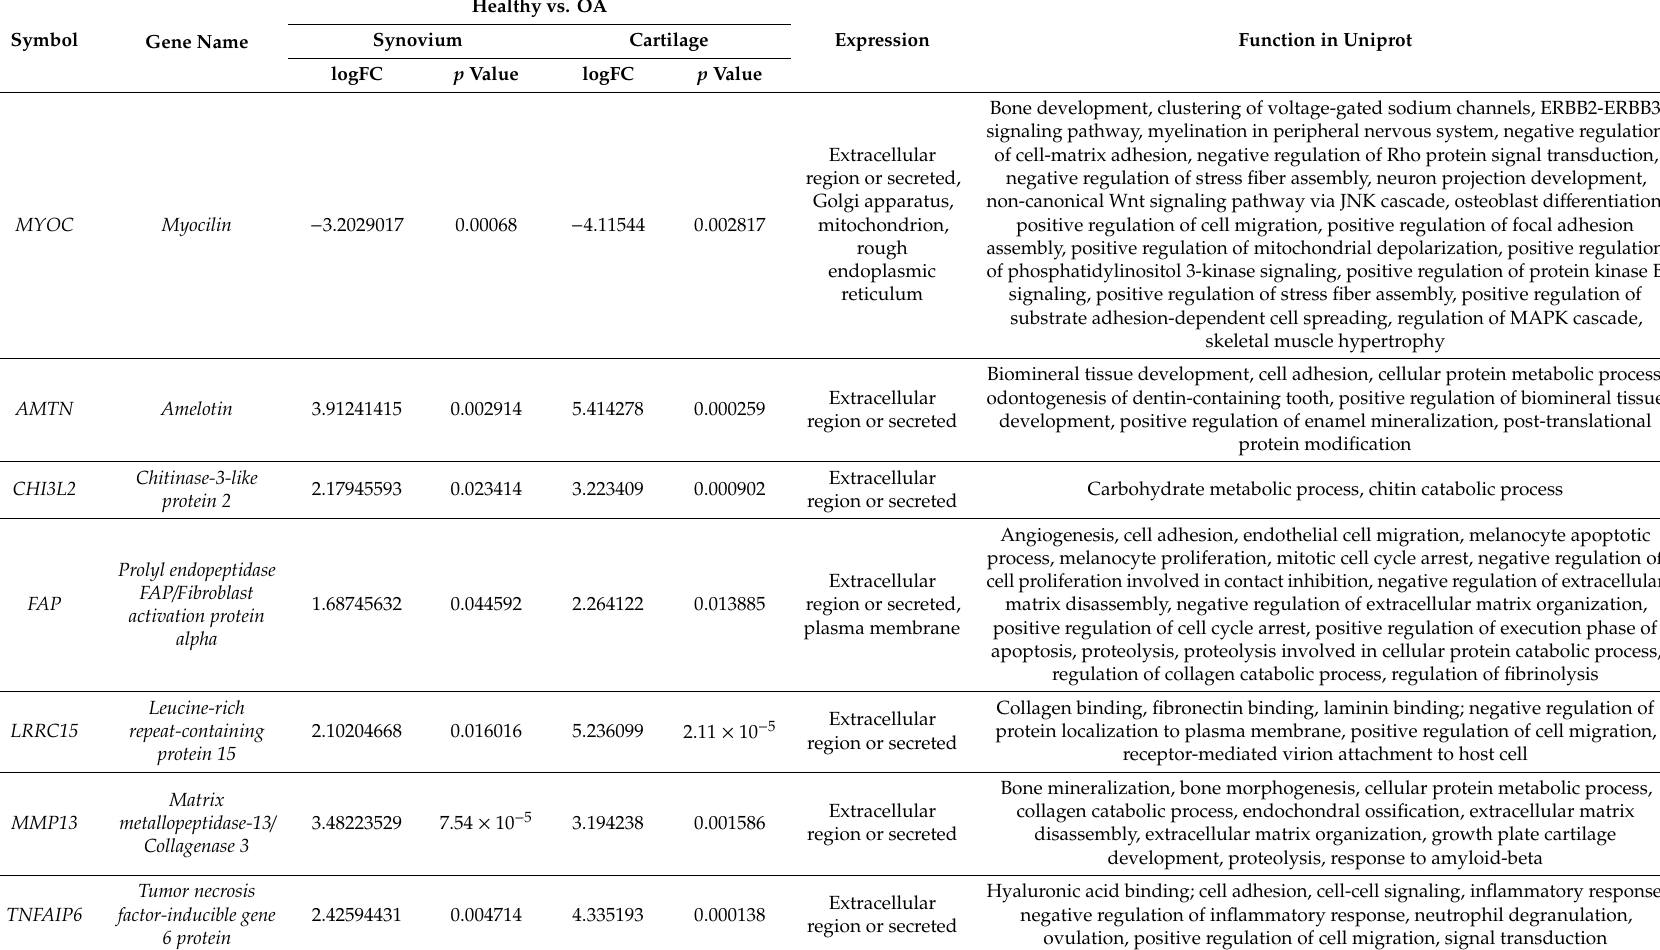
Table 2. Seven common DEGs related to “extracellular matrix (ECM) binding, formation,